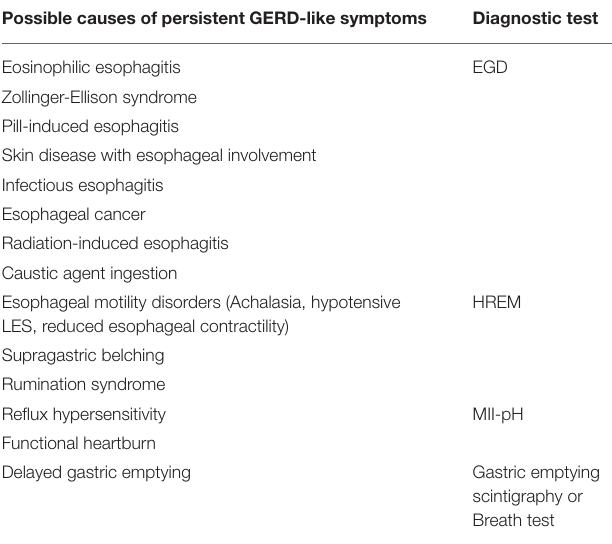
TABLE 2 | Possible causes of persistent GERD-like symptoms and corresponding diagnostic tests. Possible causes of persistent GERD-like